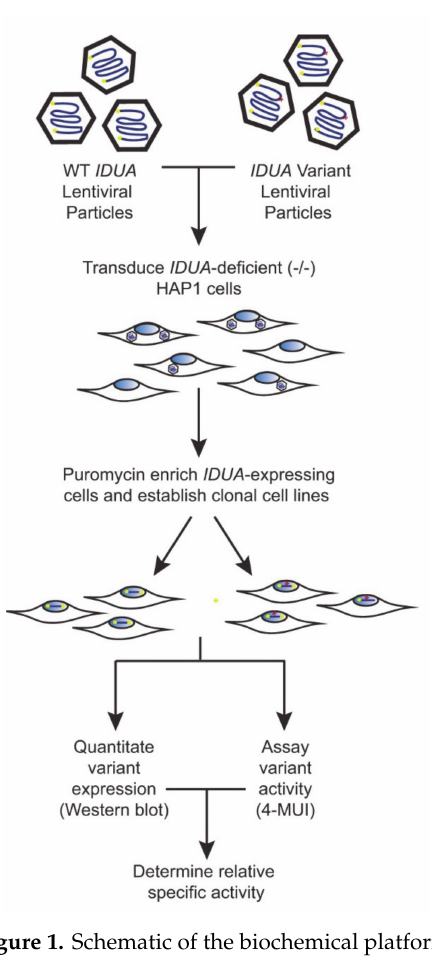
Figure 1. Schematic of the biochemical platform.